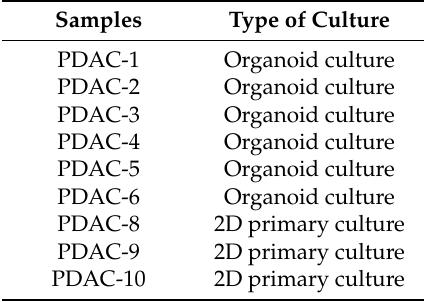
Table 1. List of PDAC cultures used in this